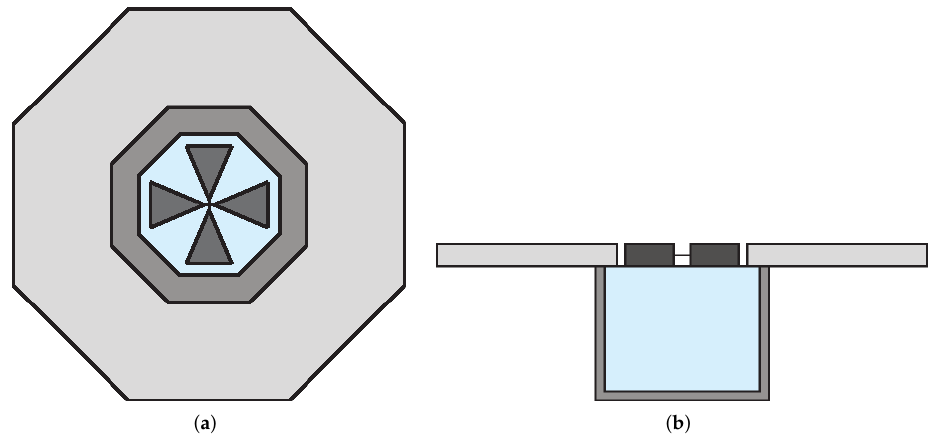
Figure 28. ( a ) Top view and ( b ) side view of the crossed bowtie antenna (redrawn from [112]). Dark gray top metal face, medium gray metal flange, light blue cavity face, and light gray dielectric substrate.